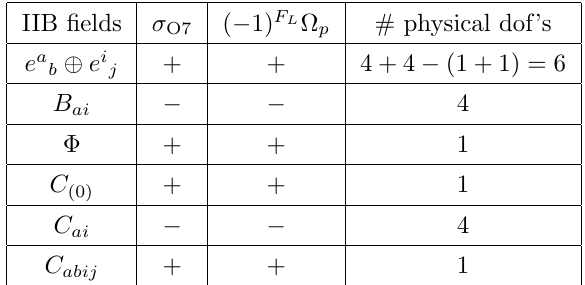
Table 19 . Counting of the total 17 propagating scalar dof’s allowed by O7-planes in type IIB compacti(cid:12)cations down to six dimensions. This is exactly the dimension of the supergravity coset given in (3.1), once we subtract from e a b and e i j the 2 unphysical directions associated to the SO(2) (cid:2) SO(2) generators.